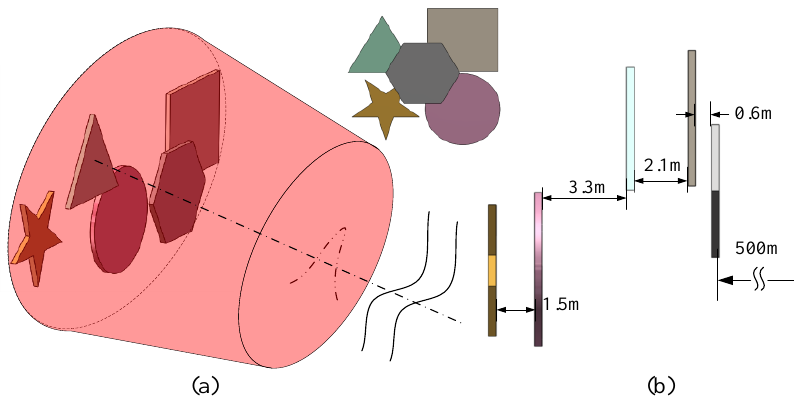
Figure 6. 3D target models: ( a ) Perspective view and ( b ) side view.